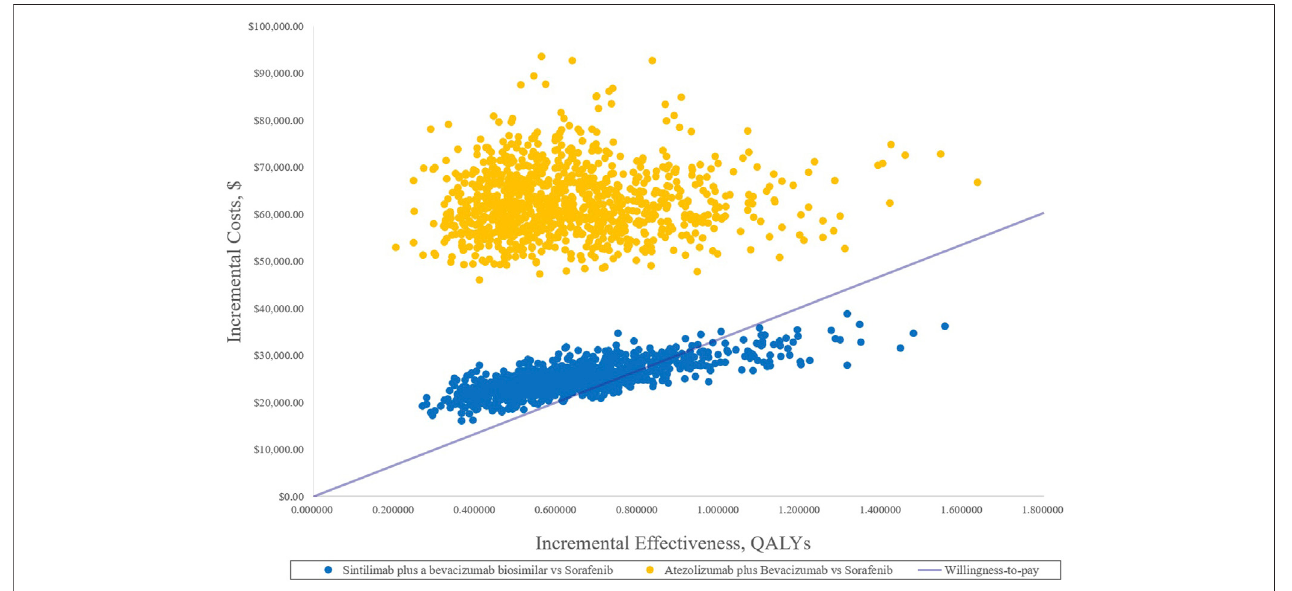
FIGURE 4 | Incremental cost-effectiveness scatterplots. QALYs, quality-adjusted life years.